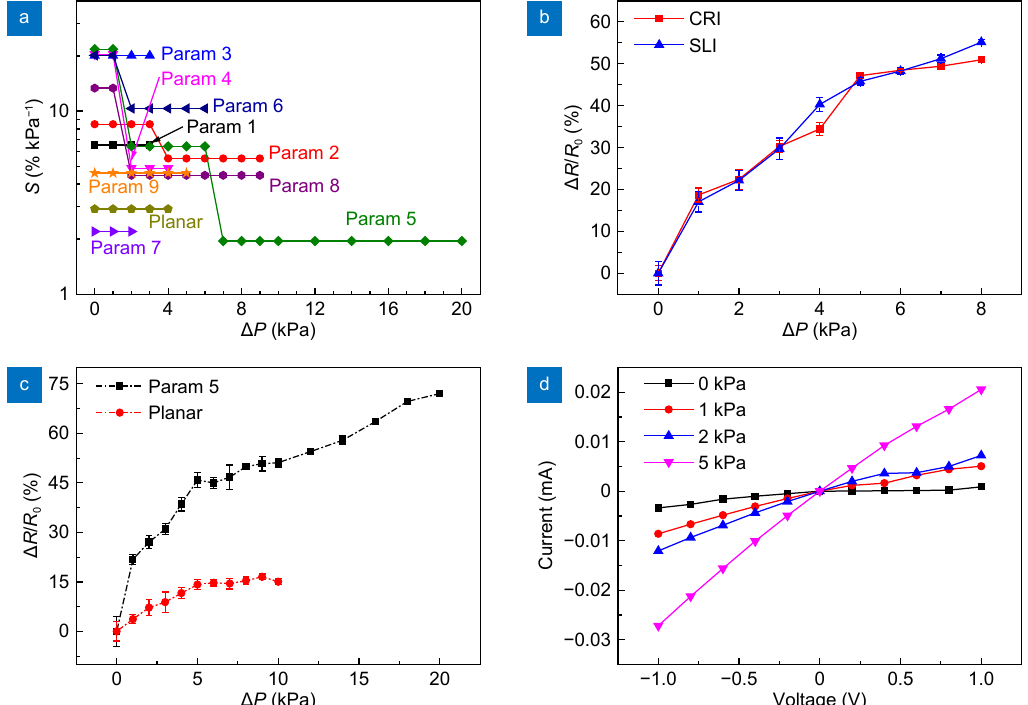
Fig. 6 | ( a ) Sensitivity properties of flexible piezoresistive sensors fabricated with different laser processing parameters. ( b ) Resistance variations with pressure of sensors packed with different interdigital electrodes within 8 kPa pressure. ( c ) Resistance variations with pressure of sensors fabricated with Param 5 and the planar one without microstructures. ( d ) I-V curves of sensor fabricated with Param 5 under different